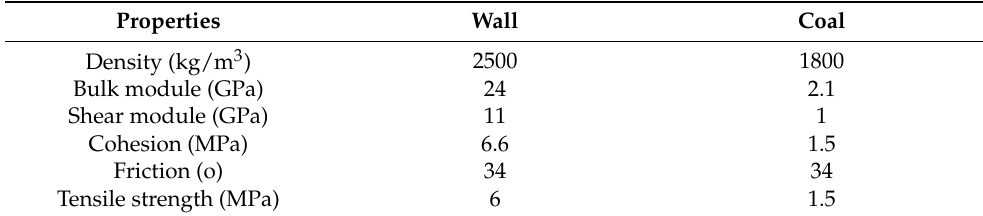
Figure 9. Geometry and dimensions of the numerical model. Table 3. Mechanical properties of the modelled materials.